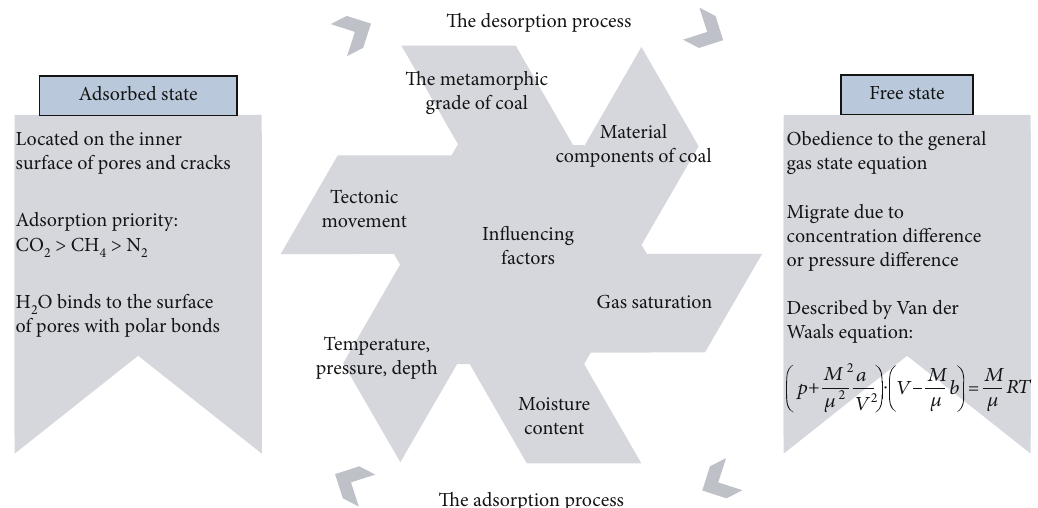
Figure 8: Dynamic equilibrium state and mutual transition process between adsorbed gas and free gas in coal reservoirs.